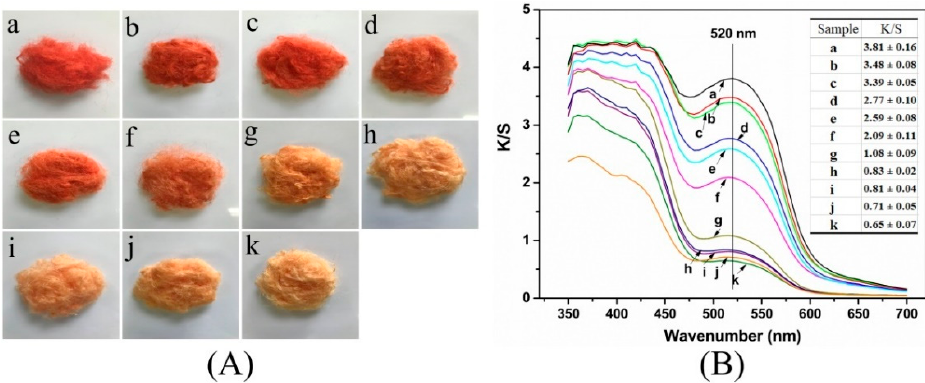
Figure 2. ( A ) Color change and ( B ) the absorption and scattering coefficient (K/S) value of silk samples after picric acid and carmine staining: ( a ) Non-degummed raw silk, ( b – j ) degummed with 0.01, 0.05, 0.1, 0.3, 0.5, 1.0, 3.0, 4.0, and 6.0 g/L papain, respectively, ( k ) degummed with 0.5 g/L Na 2 CO 3